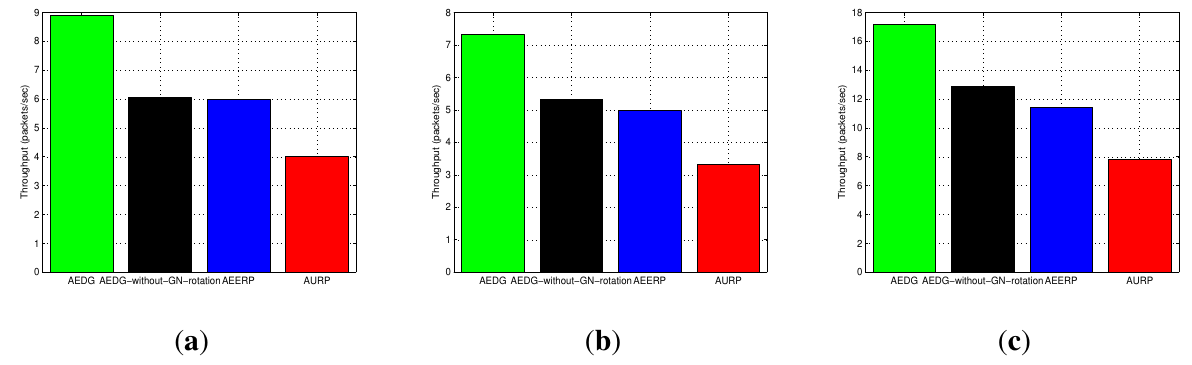
Figure 13. Network throughput. ( a ) 10 nodes deployed in 100 m × 100 m; ( b ) 100 nodes deployed in 100 m × 100 m; ( c ) 100 nodes deployed in 10 km × 10